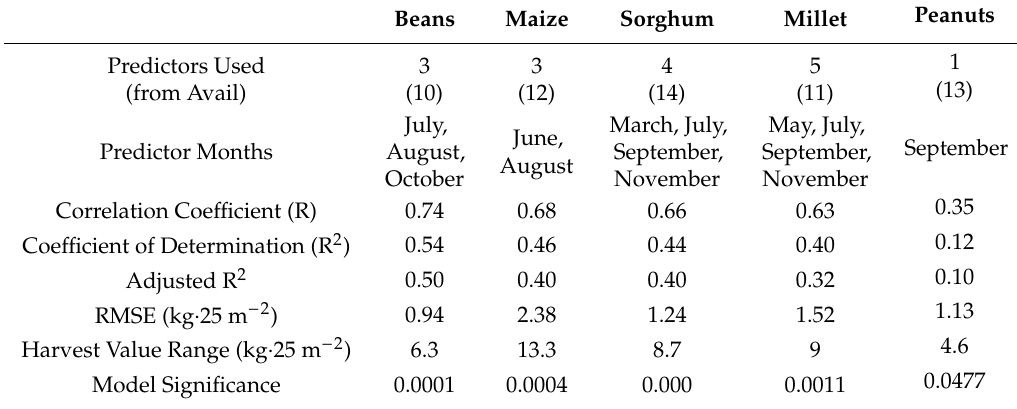
Table 1. Multiple linear regression (MLR) model outputs and model validation parameters. Beans